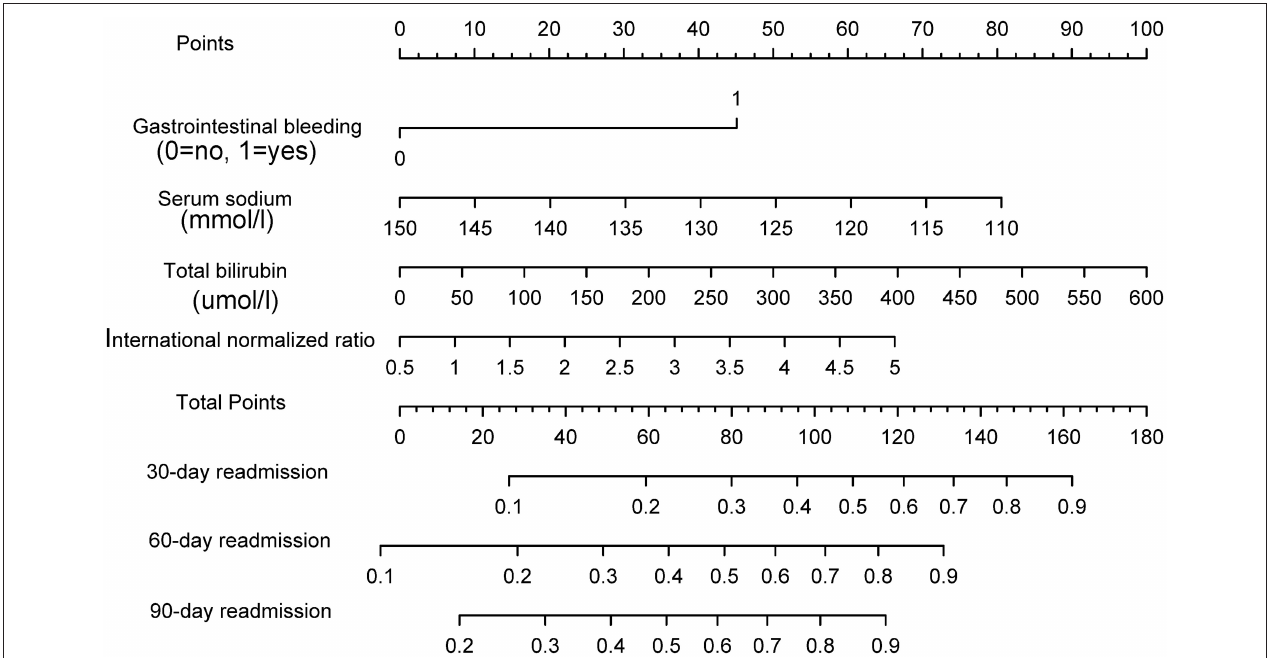
FIGURE 1 | The nomogram to predict the risk of readmission in patients with acute decompensated cirrhosis.